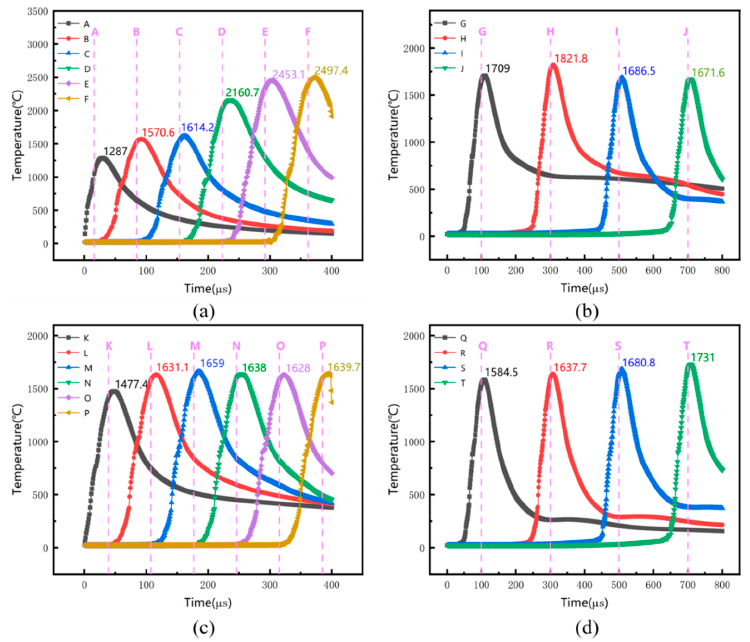
Figure 8. Temperature histories at different study points: ( a ) Layer 1; ( b ) Layer 2; ( c ) Layer 3; and ( d ) Layer